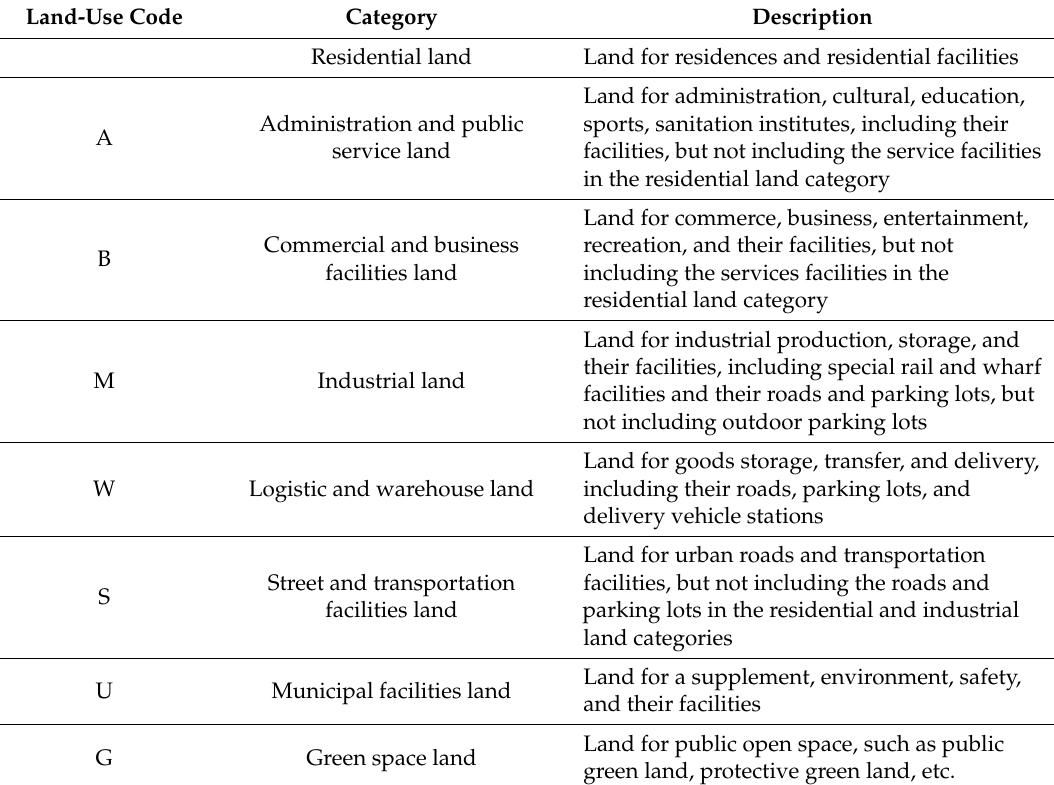
Table 2. China Urban Land-Use Classification, First Level